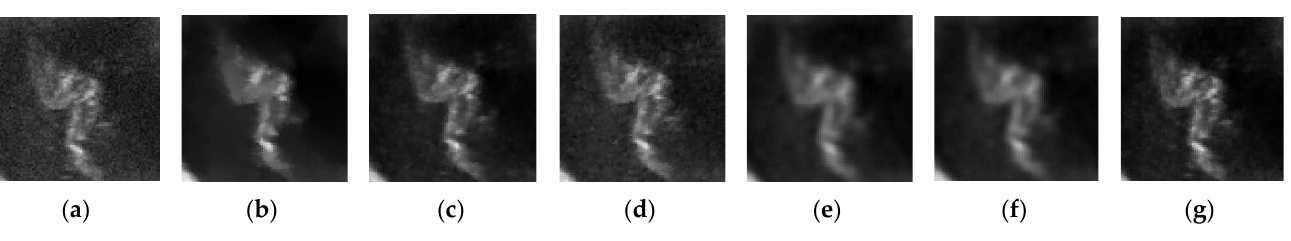
Figure 8. Magnified image of vitreous hemorrhage in part of the lesion. ( a ) Noise image. ( b ) TV model. ( c ) FTV model. ( d ) AFOTV model. ( e ) F-DSG-NLM model. ( f ) FNM model. ( g ) Our model.